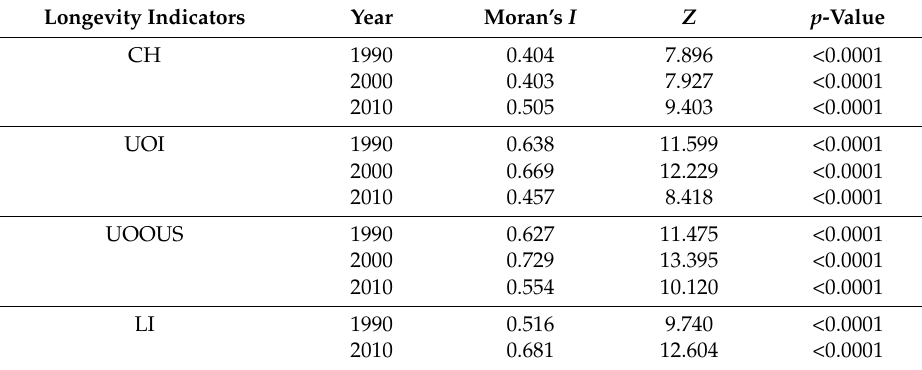
Figure 3. Hot and cold clusters of CH, UOOUS, UOI and longevity index (LI) using Getis-Ord G* statistics. Table 1. Global spatial autocorrelations of lifespan indicators from 1982 to 2010.